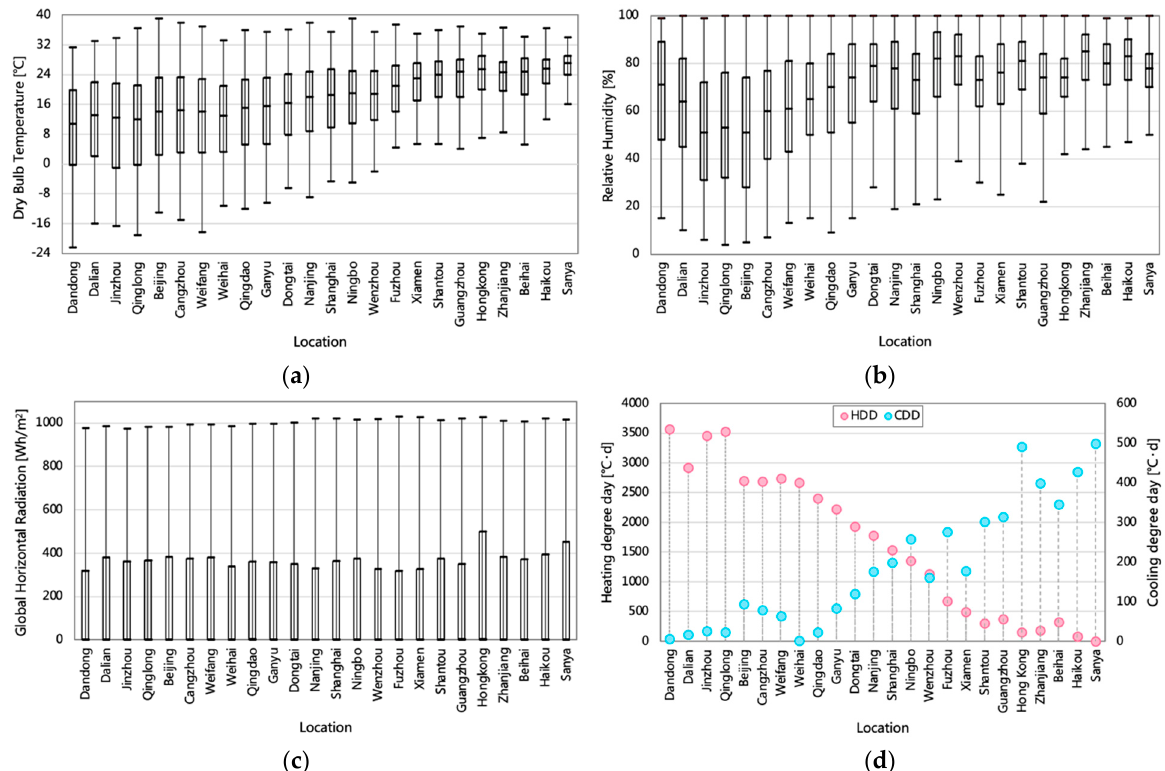
Figure 5. Analysis of EPW weather data in 24 coastal cities: ( a ) DBT; ( b ) RH; ( c ) GHR; ( d ) HDD and CDD.